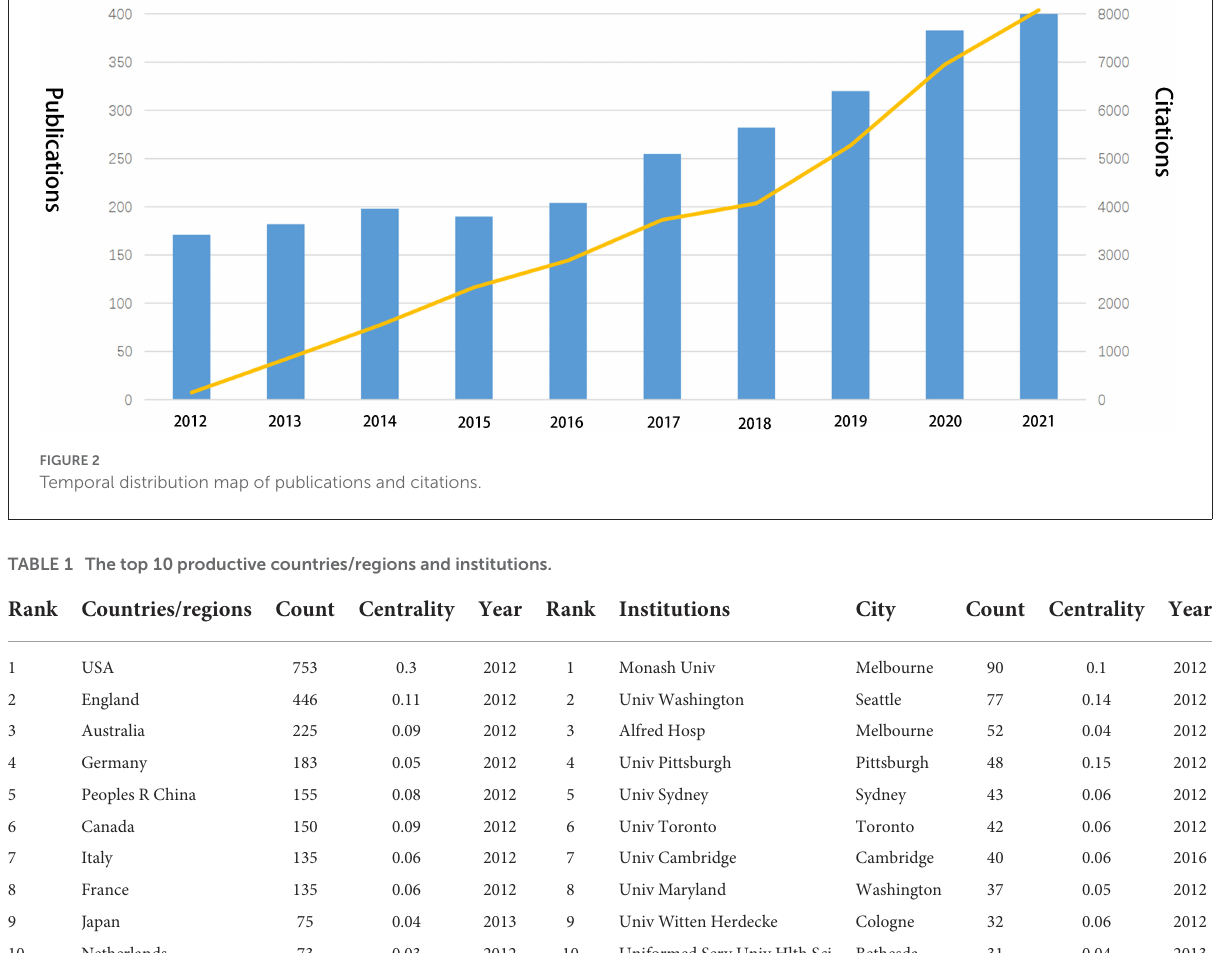
University of Washington (77), and Alfred Hospital (52). In Figure 3, the purple ring indicates the centrality of literature (19). Some countries and institutions had high centralities, such as the USA (0.3), England (0.11), the University of Pittsburgh (0.15), the University of Washington (0.14), and Monash University (0.1). Links between nodes signify relationships of collaboration (19), and dense connections indicate active cooperation among countries and